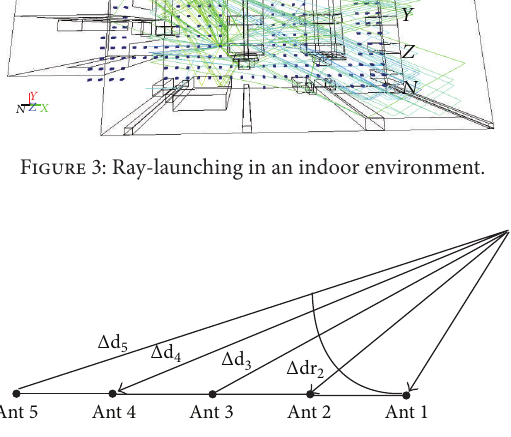
Figure 4: An illustration of the phase-shift model in a linear